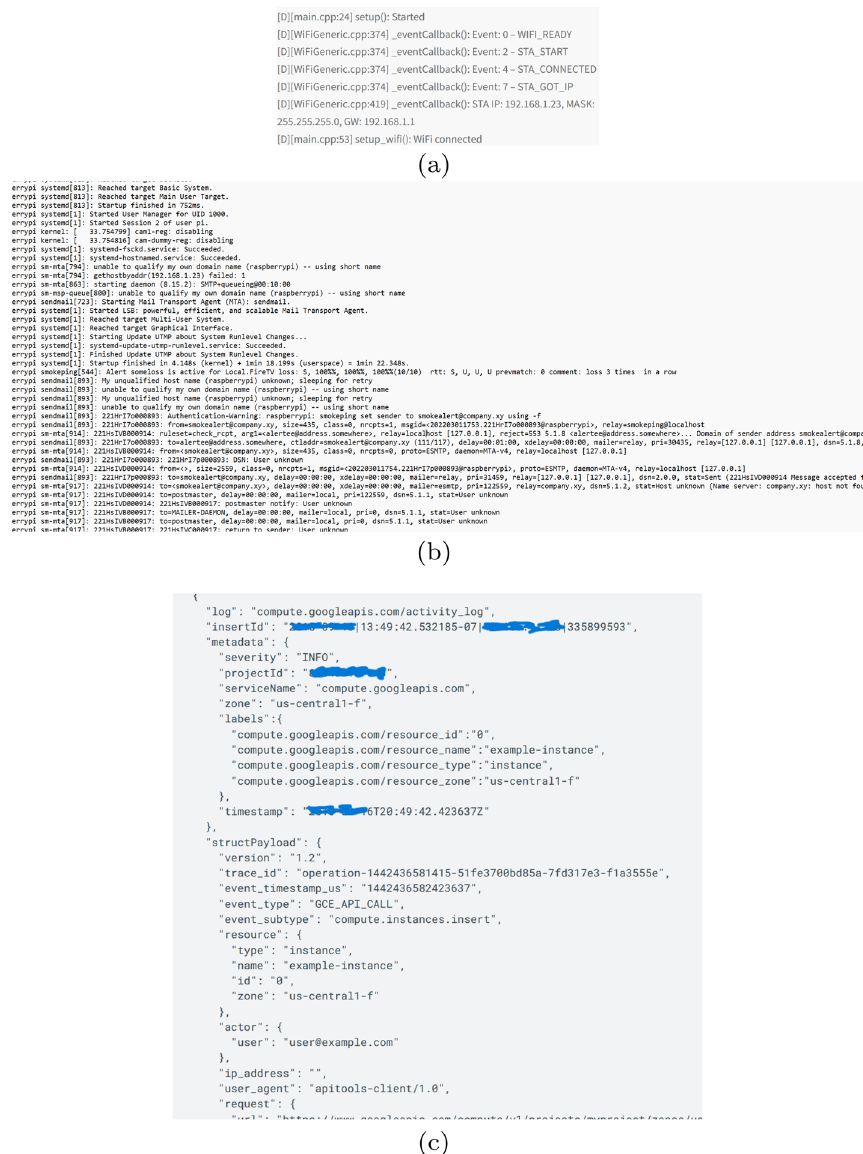
Fig. 1 Example for System log files of different devices in DCCS a Arduino b Raspberry Pi ( c ) Cloud server